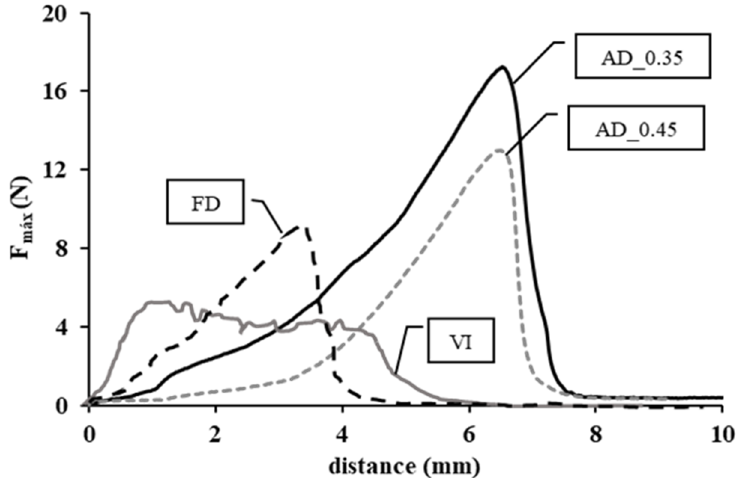
Figure 2. Typical force (in N) vs. distance (in mm) curves obtained after the puncture tests for apple samples impregnated with liquid 0% _0MPa (VI) and further freeze-dried apple (FD) or air-dried at 40 °C until a final water activity of 0.45 (AD_0.45) or 0.35 (AD_0.35).